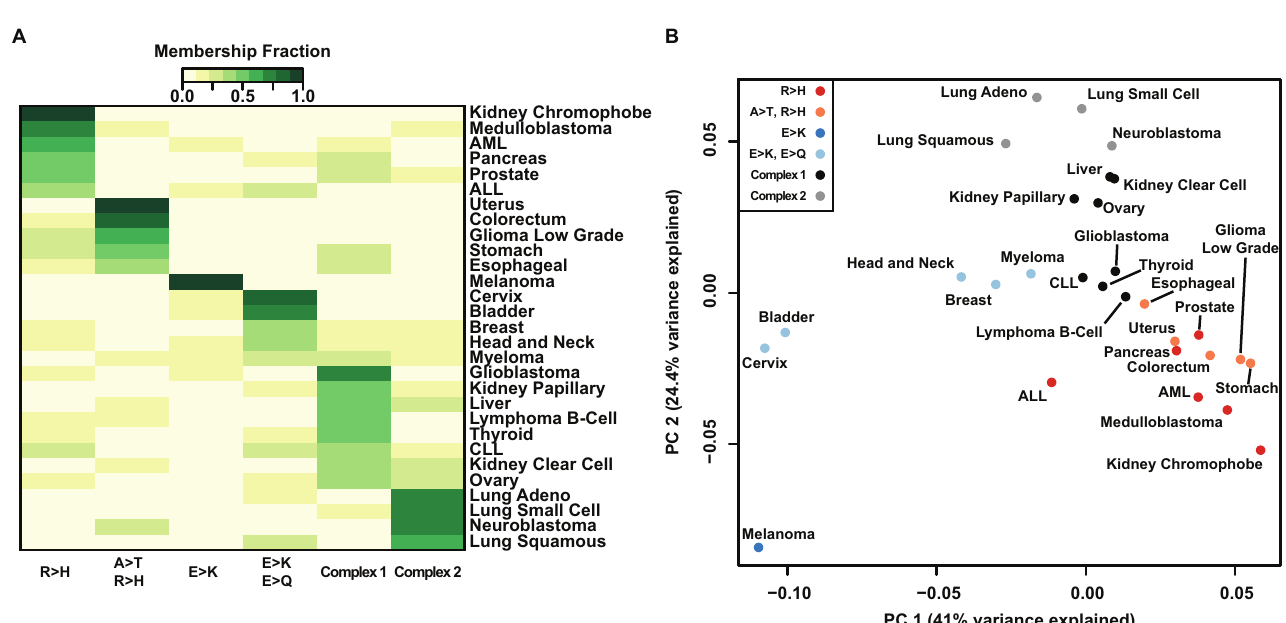
Fig 1. Arg > His and Glu > Lys mutations define mutation signatures of a subset of cancers. (A) Heatmap representation of six-component NMF clustering. Of the six amino acid mutation signaturesidentified,four have prominentcharge-changingmutations: Arg > His(R > H), Glu > Lys(E > K), or Glu > Gln(E > Q). Two complex signatures were also identified.Color scale represents scaled contributionof each signaturefor a given cancer type. Signatureand NMF fit detailscan be found in S1 Fig. (B) Principalcomponentanalysisof nonsynonymous amino acid mutations. PC1 separates cancers with high R > H from cancers with high E > K; PC2 separates cancers with complex signatures. Colors represent the greatest mutation signaturecontributing to a given cancer. Individual PC loadingscan be found in S2 Fig.